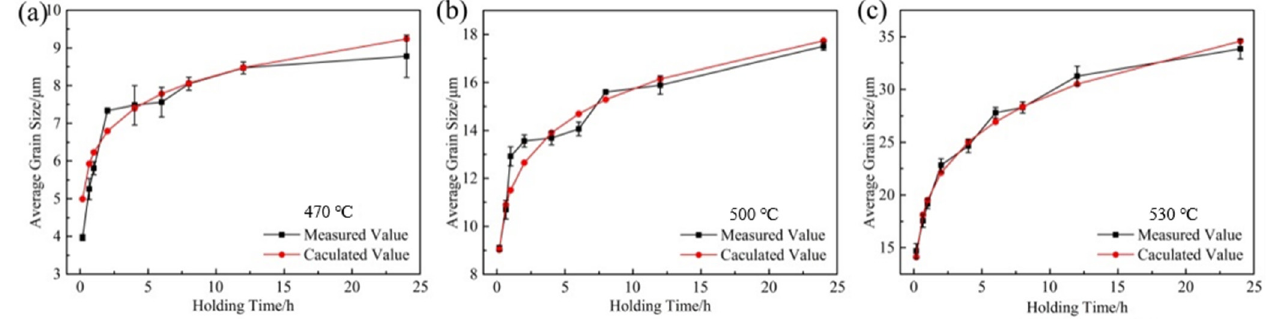
Figure 5. The curves of average grain size versus holding time pieces at ( a ) 470 °C, ( b ) 500 °C, and ( c ) 530 °C.